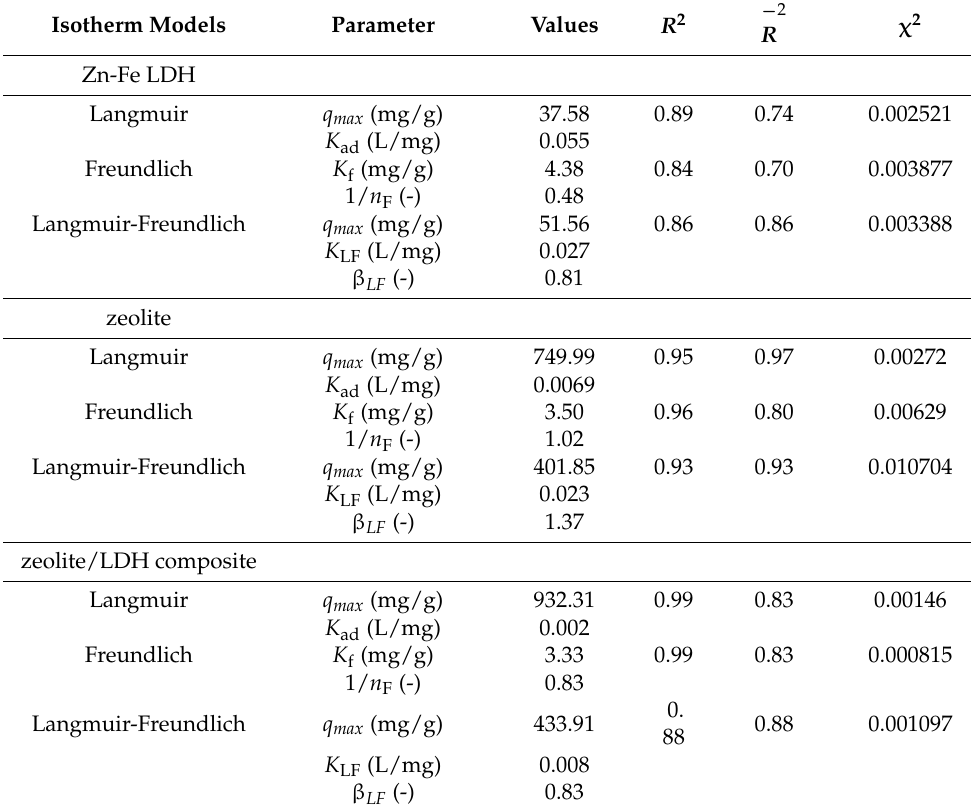
Table 4. The parameters of the adsorption models for MB sorption onto Zn-Fe LDH, zeolite, and